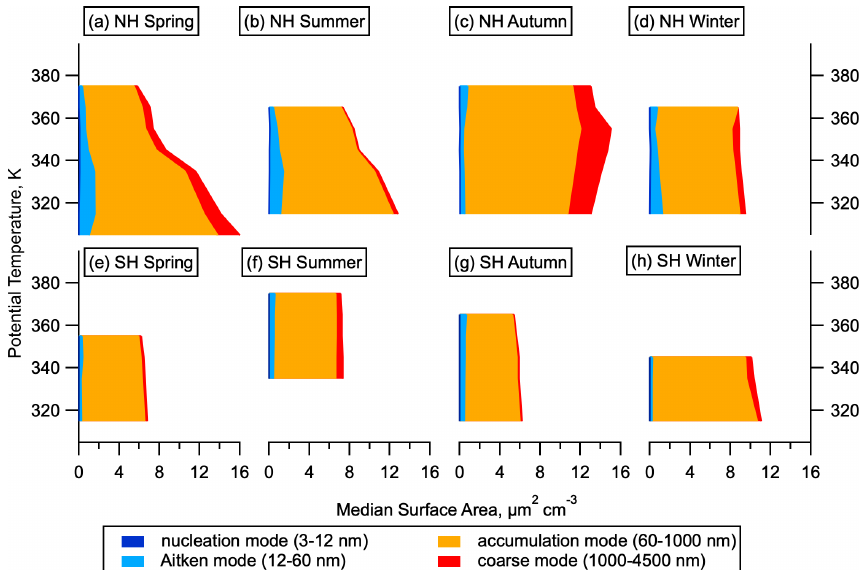
Figure 4. Aerosol surface area in the LMS. Aerosol surface area in the LMS as a function of potential temperature, separated by mode (colours) and season for the NH ( a–d ) and SH ( e–h ). Mode size ranges are 3–12nm (nucleation), 12–60nm (Aitken), 60–1000nm (accumu- lation), and 1000–4500nm